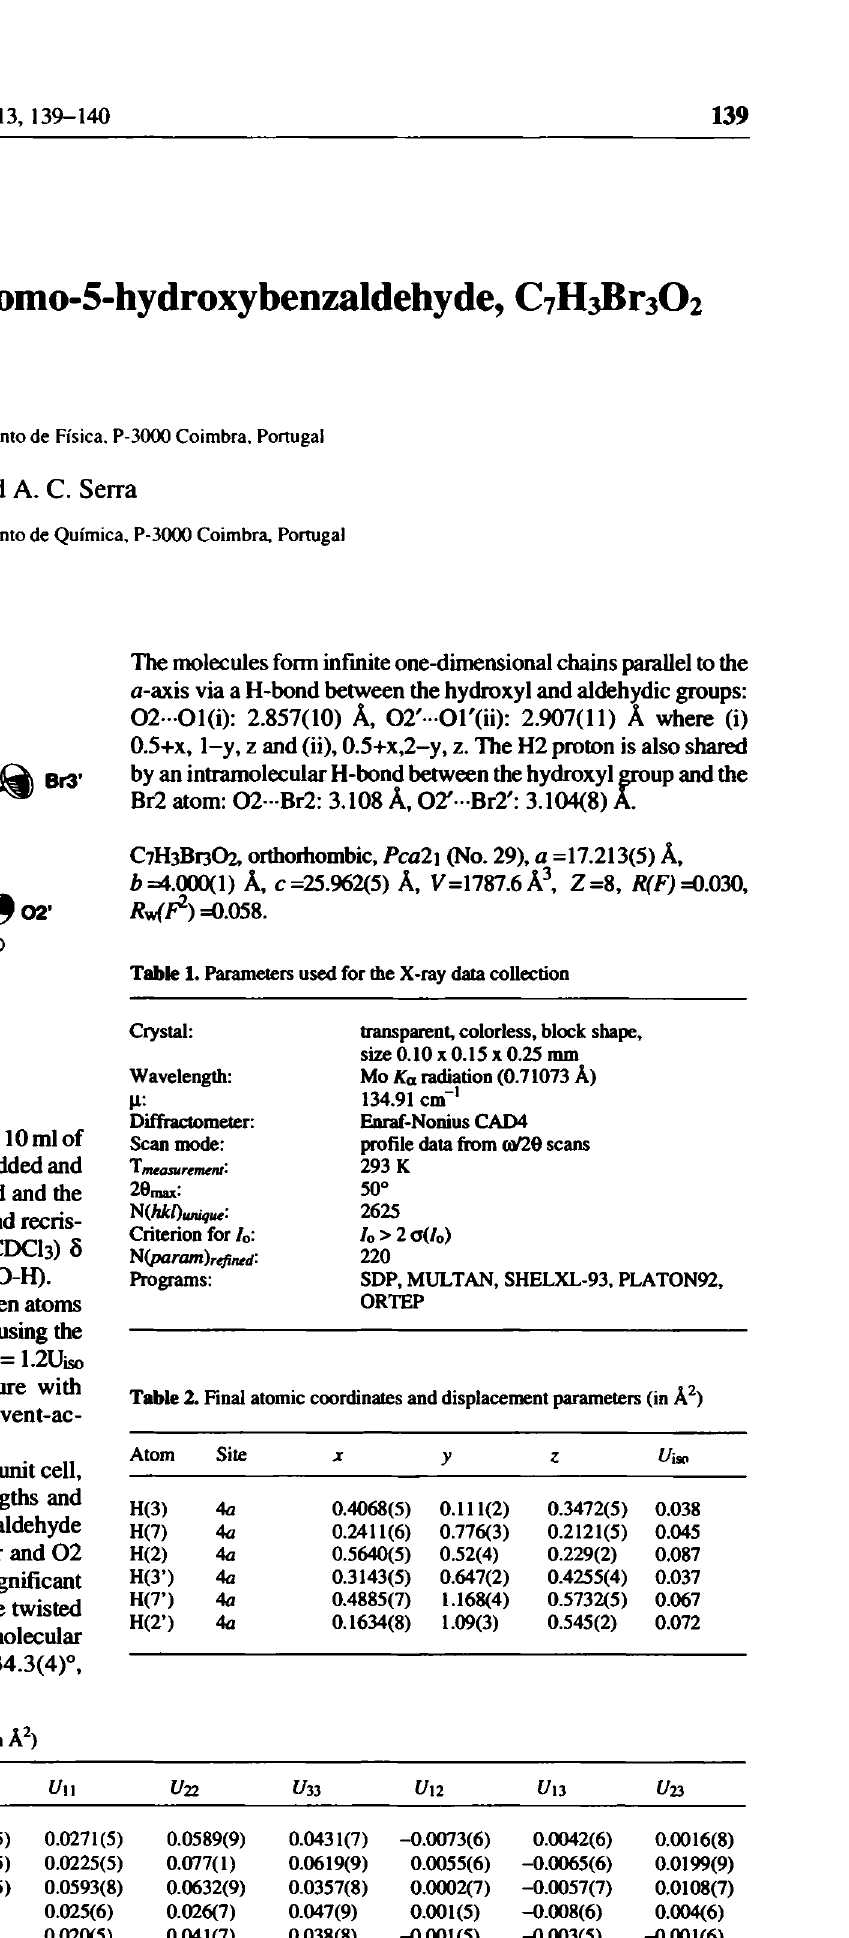
Table 3. Final atomic coordinates and displacement parameters (in A^)